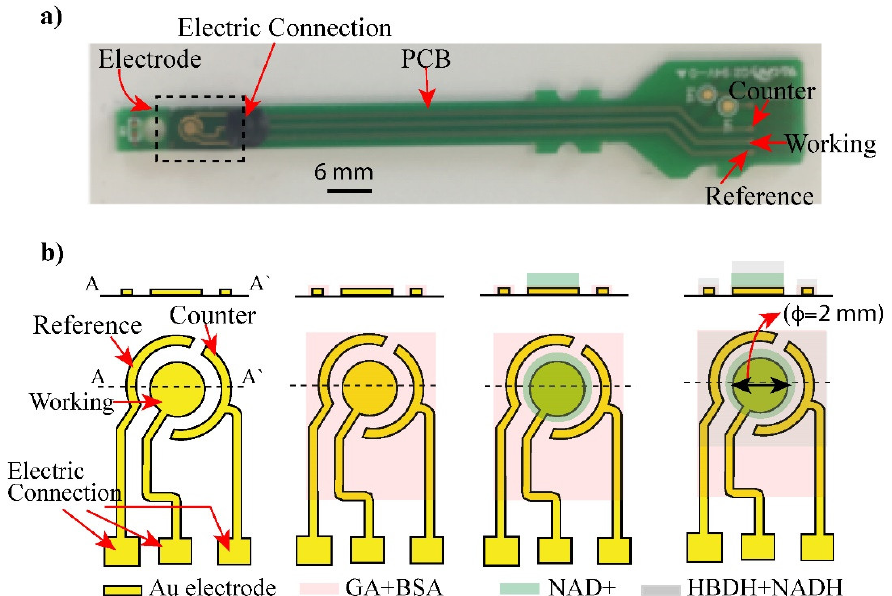
Figure 1. Layout of biosensor: ( a ) an electrode and its connected PCB was displayed. ( b ) Shape and structure of the electrode (Working, Counter and reference electrode) was illustrated. The electrode was coated with glutaraldehyde (GA) and bovine serum albumin (BSA) to form crosslinking with enzymes. Layers of NAD+ and mixture of HBDH and NADH were deposited on the electrode surface and addition of AcAc caused enzyme reaction.